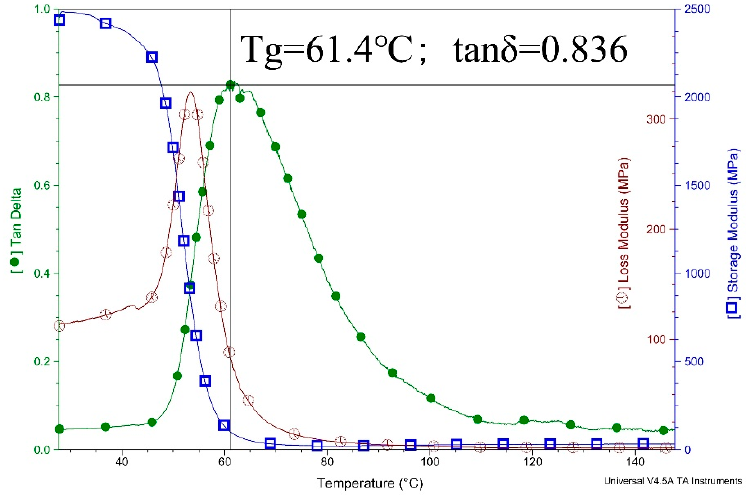
Figure 9. Dynamic thermomechanical analysis of binder material E44.